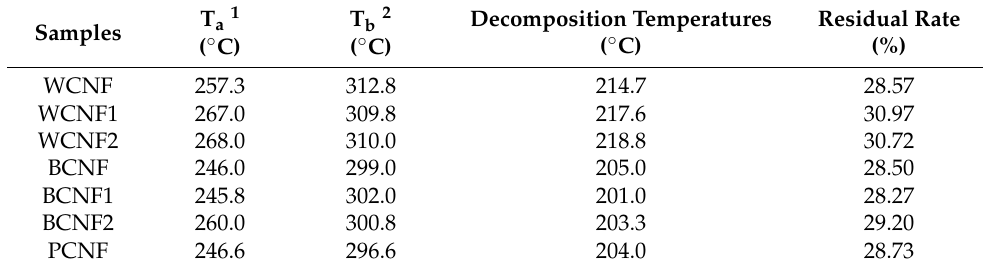
Table 3. Thermal data from TG analysis of the